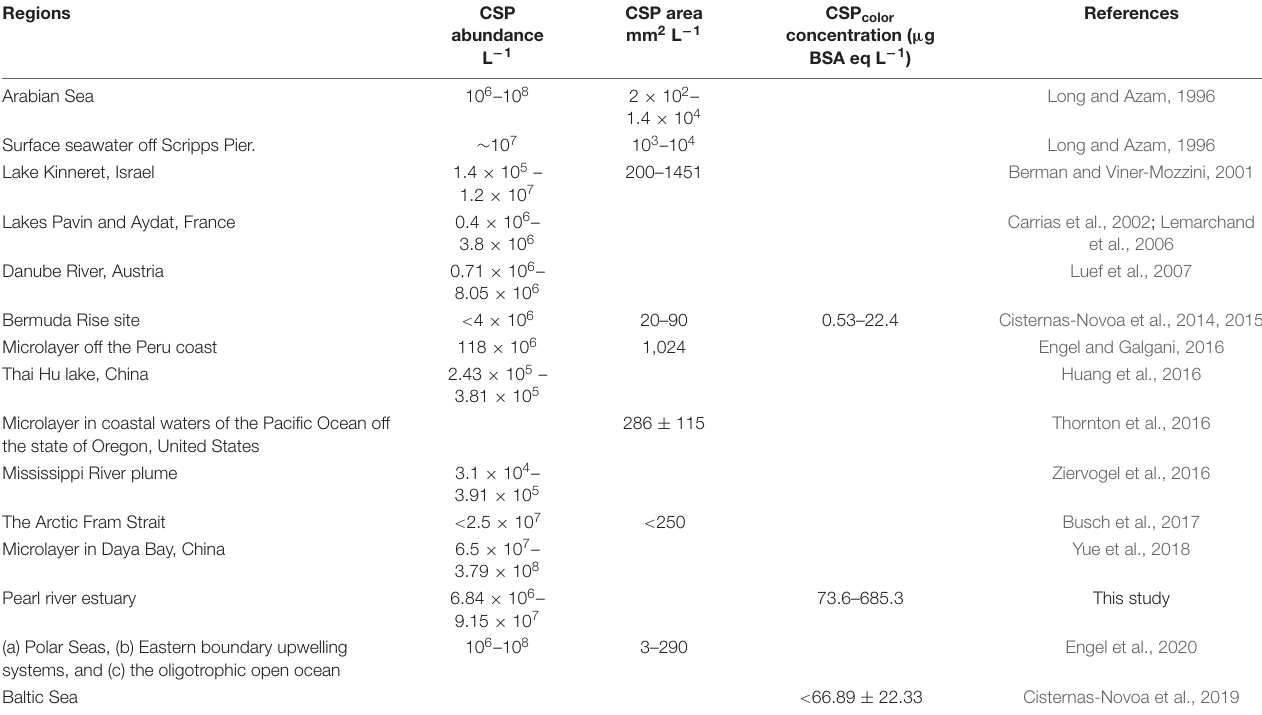
TABLE 3 | CSP concentrations in different regions.